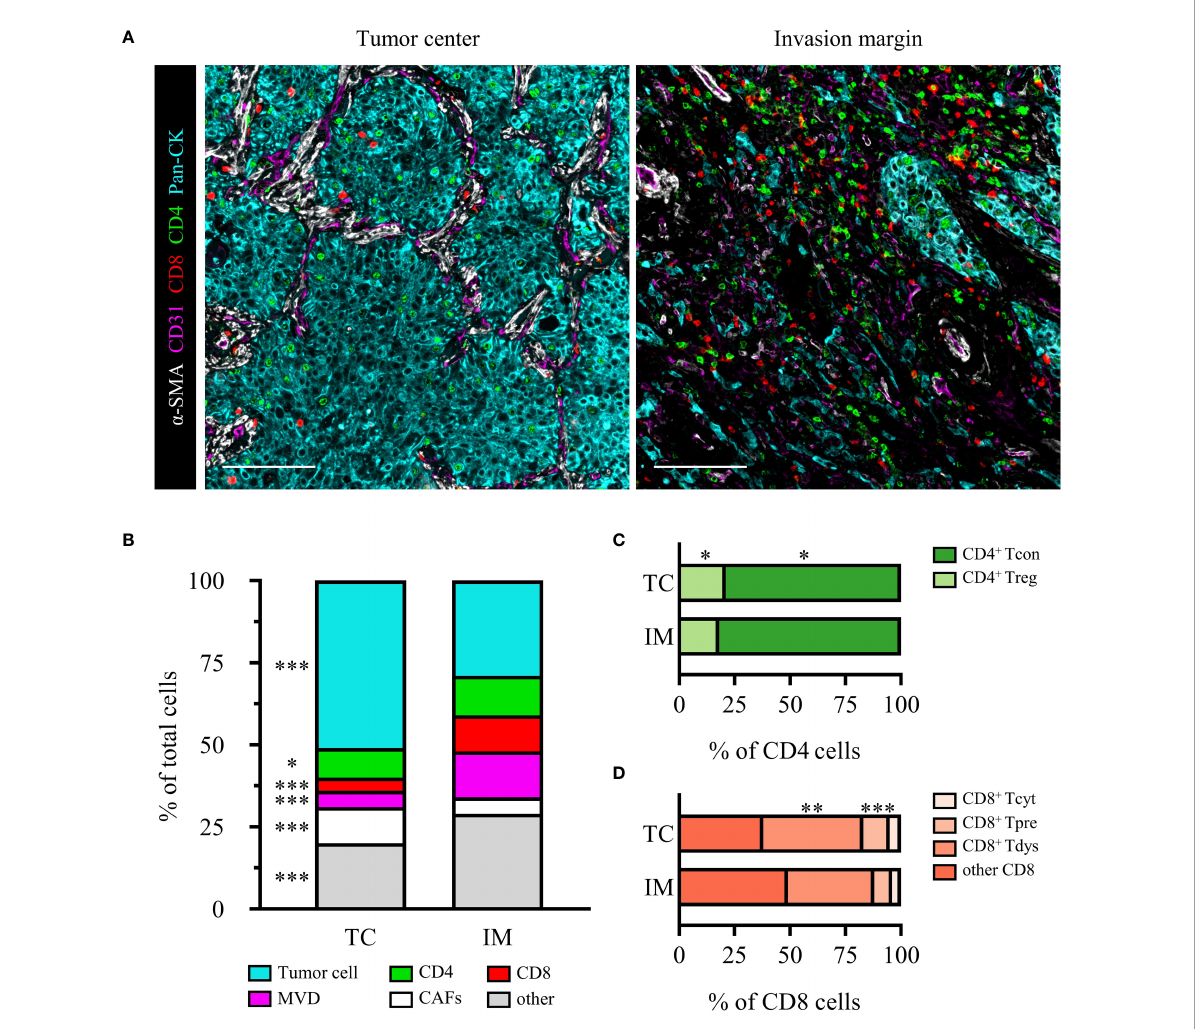
FIGURE 2 The heterogeneity of TC and IM microenvironment in locally advanced NSCLC. (A) Representative composite images of TC and IM from an SCC patient. Scale bar, 100 m m. (B) Relative distribution of cell phenotypes in TC and IM. Relative distribution analysis of CD4 (C) or CD8 (D) subpopulations. Scale bar, 100 m m. Data is presented as the median. P values were computed by the Kruskal-Wallis test. *P < 0.05, **P < 0.01, ***P <